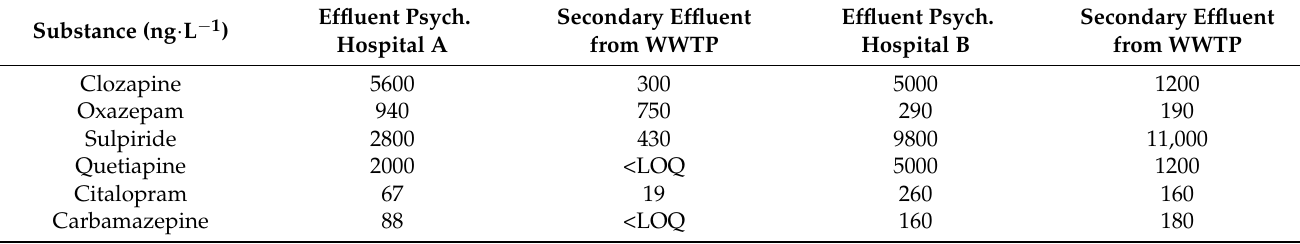
Table 3. Average drug concentrations determined in the effluent from psychiatric hospitals (A, B) and at the effluent of the relevant WWTP